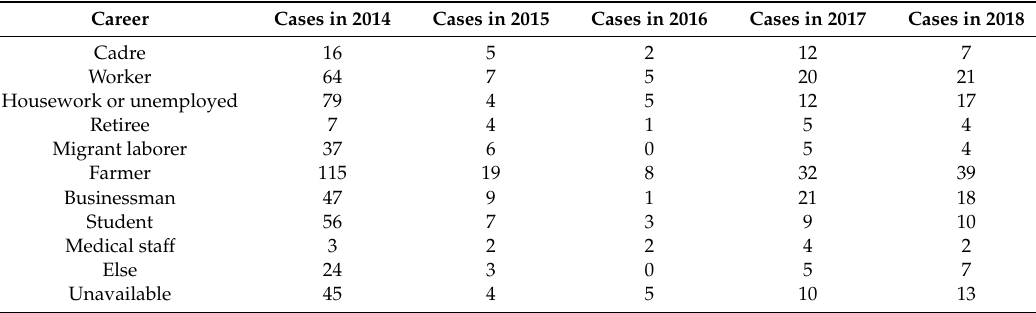
Table 4. Career distribution of domestic imported dengue fever from